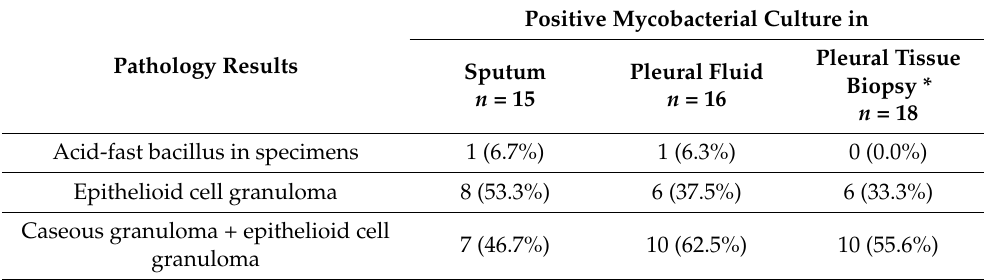
Table 2. Positive TB cultures of the TB pleurisy patients by pathology classification.